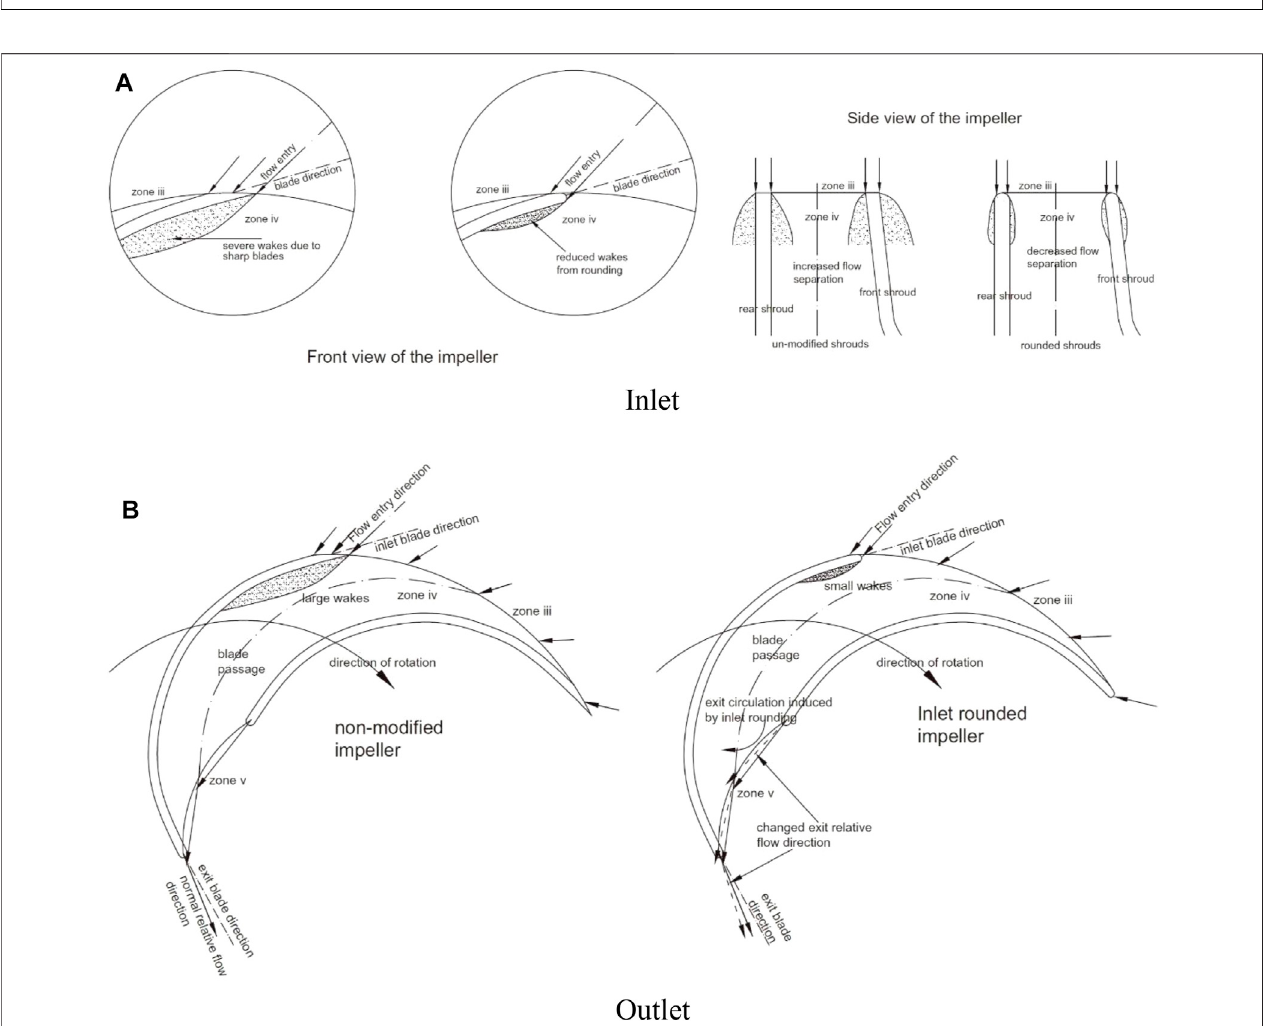
FIGURE 6 | Physical understanding of blade rounding effects at inlet and outlet (Singh and Nestmann, 2011). (A) Inlet, (B) Outlet.